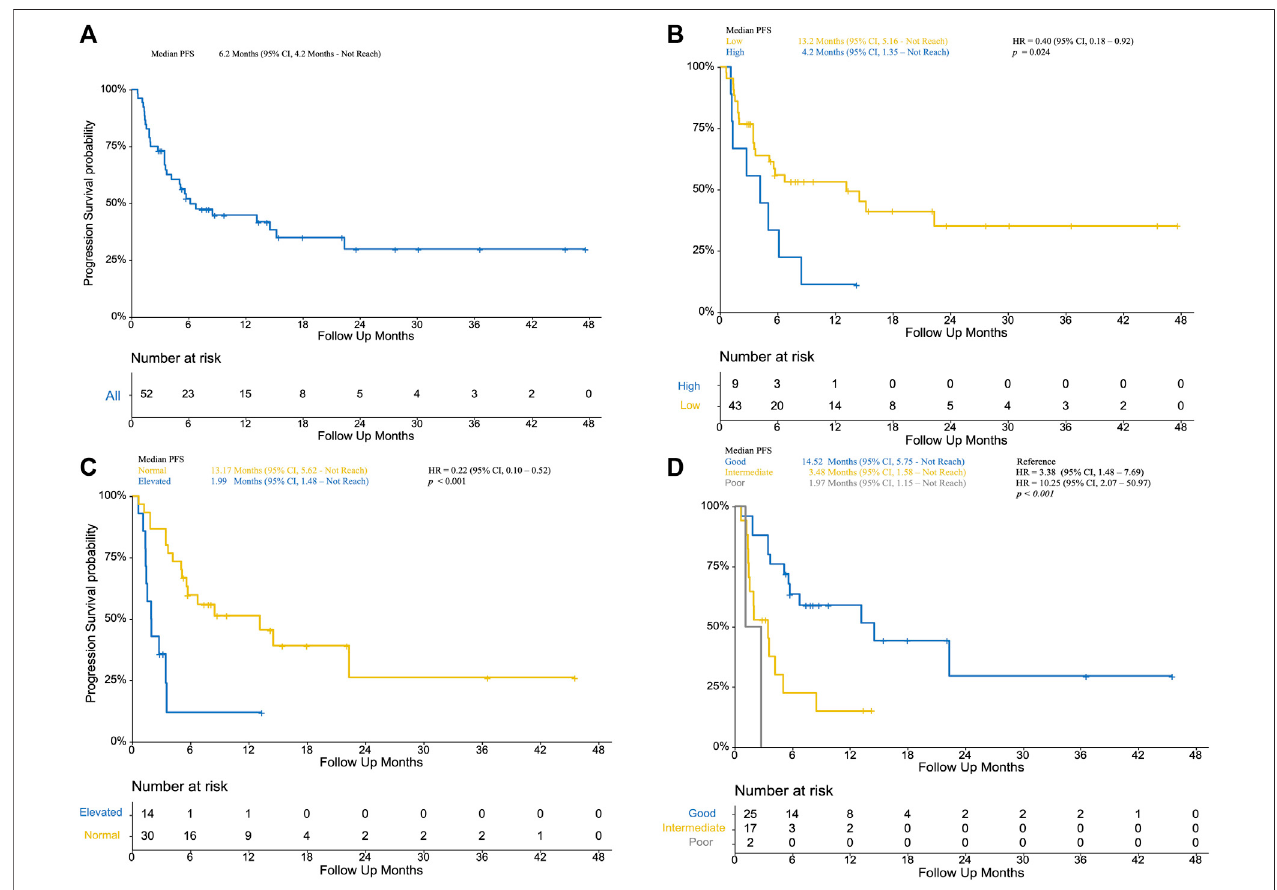
FIGURE 1 | (A) : Progression-free survival of included patients; (B) Kaplan – Meier curve of low NLR patients (yellow) and high NLR (blue, as reference) patients; (C) Kaplan – Meier curve of normal LDH (yellow) and elevated LDH (blue, as reference); (D) Kaplan – Meier curve of poor mUIPI (gray), intermediate mUIPI (yellow), and good mUIPI (blue, as